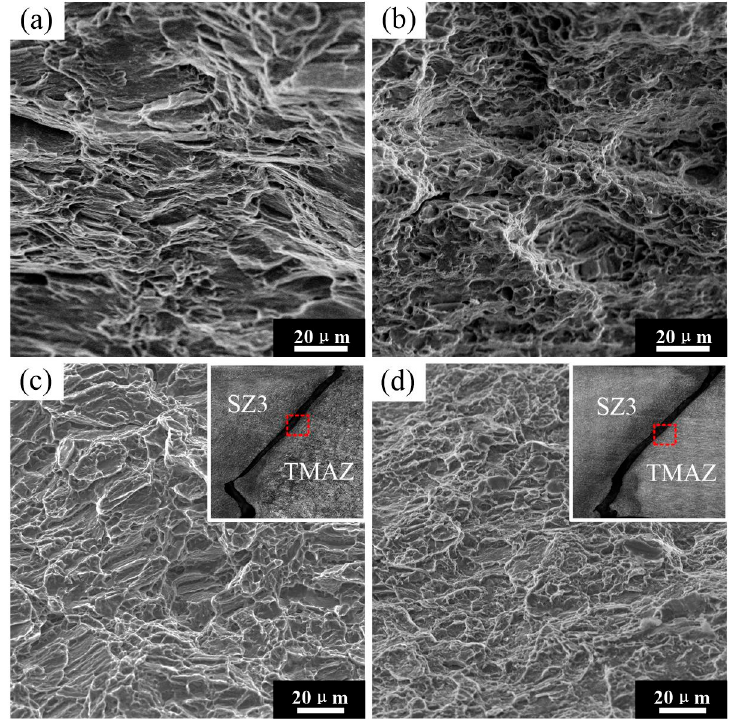
Figure 13. SEM images showing fracture surfaces: ( a ) ATZ511BM, ( b ) ZK60 BM, ( c ) ZK60/ATZ511 joint, ( d ) ATZ511/ZK60